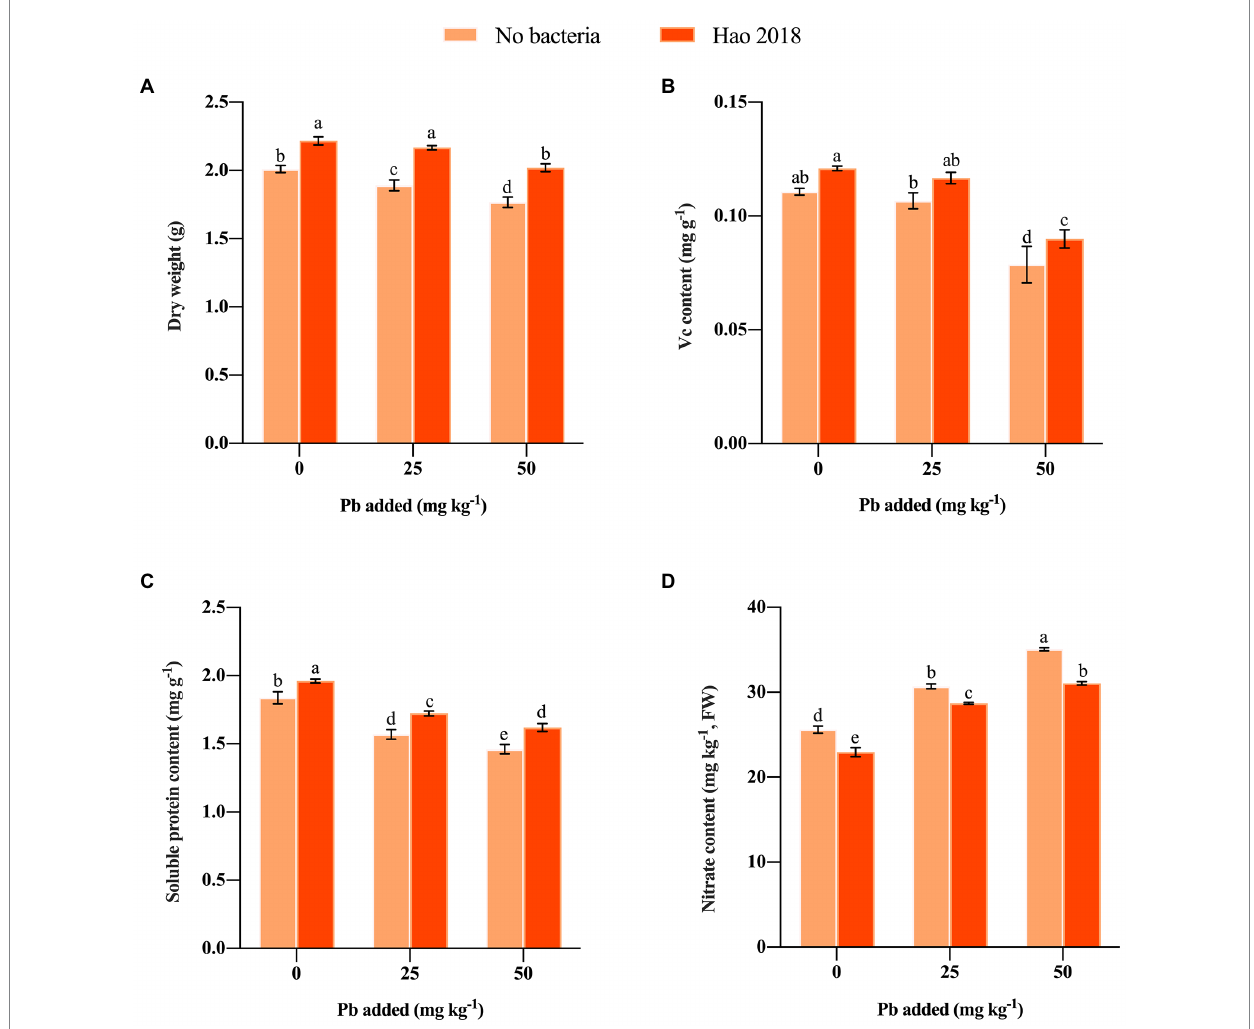
FIGURE 3 Effect of Hao 2018 on biomass (A) , vitamin C (Vc) (B) , soluble protein (C) and nitrite content (D) of the edible tissues of pakchoi. Each bar represents the mean ± SD ( n = 3). Values followed by the same letter were not significantly different ( p >